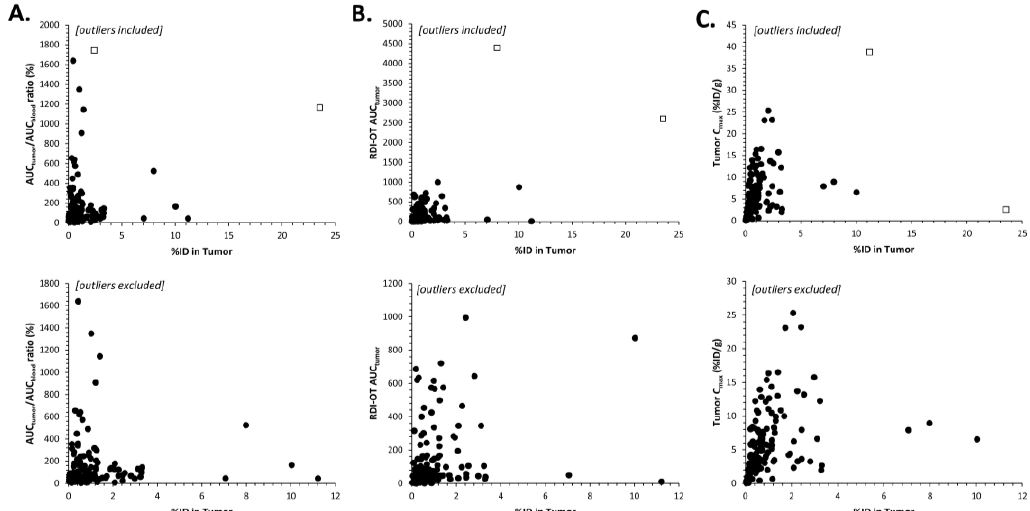
Figure 5. Correlation plots for all data sets between %ID in Tumor (per Wilhelm et al.) and AUCtumor/AUCblood ratio (%) ( A ), RDI-OT AUCtumor ( B ), and tumor Cmax ( C ). Plots are shown with all data sets (outliers shown as (cid:3) ) and with outliers excluded. There was no relationship between %ID in Tumor and AUCtumor/AUCblood ratio (%) [ ρ = 0.183 all data (AD); ρ = 0.151 excluding outliers (EO)] and a weak relationship between %ID in Tumor and RDI-OT AUCtumor ( ρ = 0.319 AD; ρ = 0.289 EO). There was a moderate relationship between %ID in Tumor and the tumor Cmax ( ρ = 0.562 AD; ρ = 0.572 EO). Reproduced and modified under Creative Commons Attribution NonCommercial License 4.0 (CC BY-NC) from Price et al. Sci Adv. 2020;6(29):eaay9249.